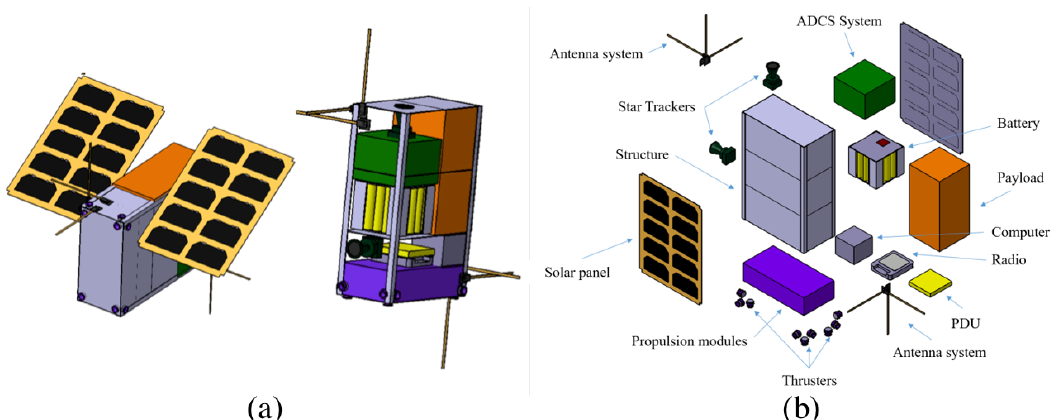
Figure 7. Exterior view ( a ) and exploded view ( b ) of the preliminary design for L2-CalSat. ADCS is the Attitude Determination and Control System, referred as AOCS in the text. PDU is the Power Distribution